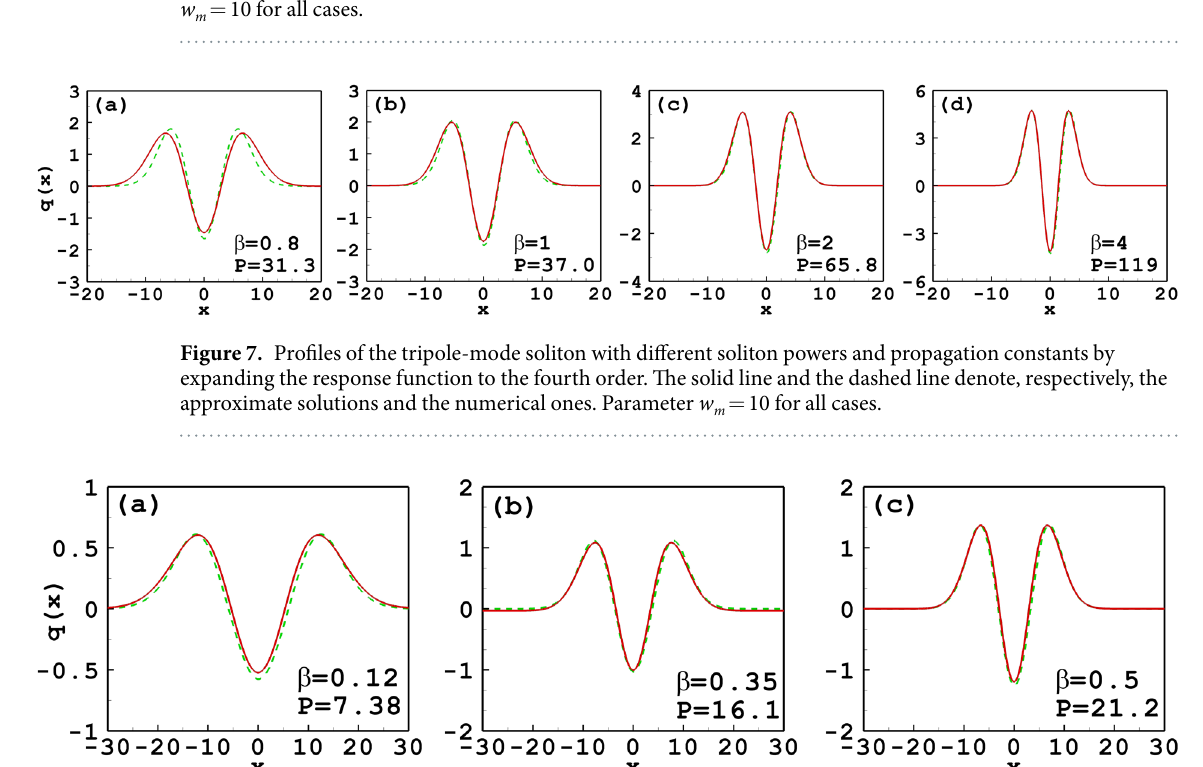
Figure 6. Profiles of the quadrupole-mode soliton with different soliton powers and propagation constants. The solid line and the dashed line denote, respectively, the approximate solutions and the numerical ones. Parameter w m = 10 for all cases.